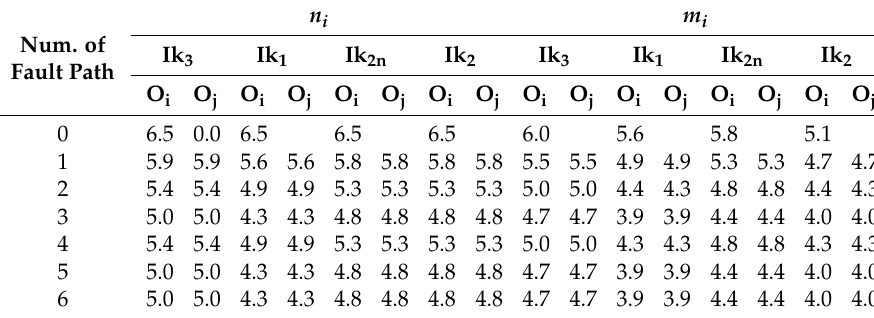
Table 8. Radial power system maximum short-circuit contributions (all values in kA).